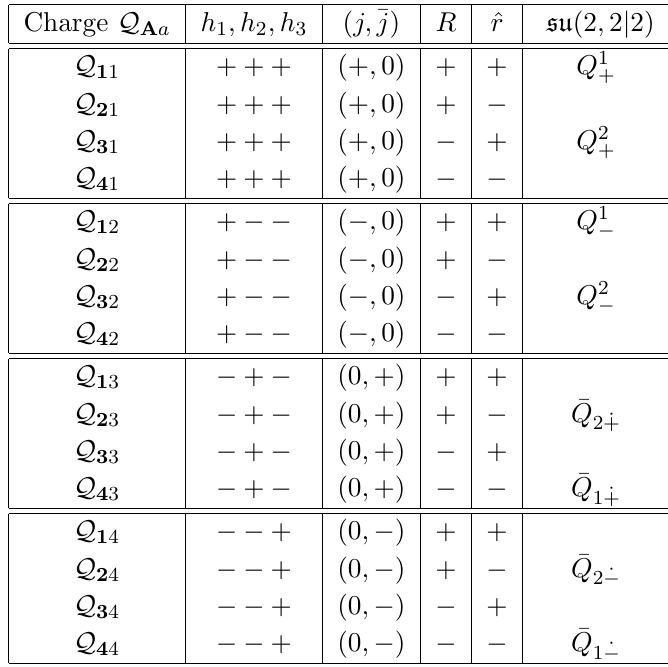
. The four-dimensional subalgebra acts on the h 2 and 2